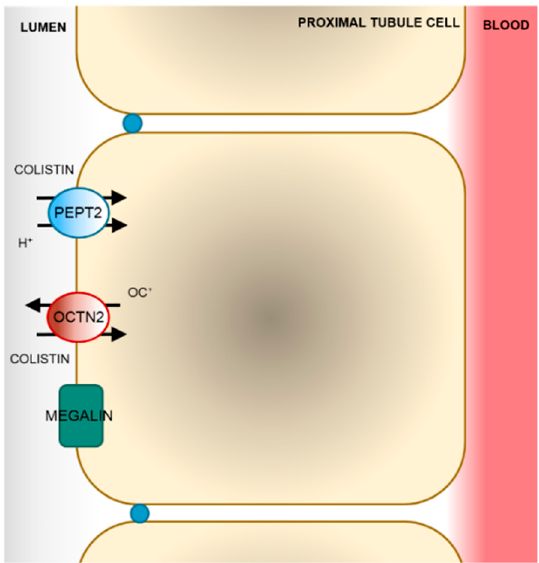
Figure 4. Model of colistin re-absorption in proximal tubule cells. After glomerular filtration, colistin is taken up by proximal tubule cells by facilitative transport mediated by the human peptide transporter 2 (PEPT2) and the carnitine/organic cation transporter 2 (OCTN2) and by the megalin-mediated endocytosis.